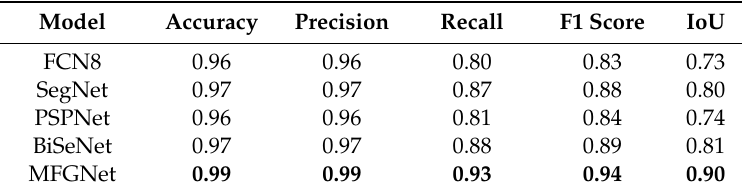
Table 3. Performance of different methods for cloud detection.